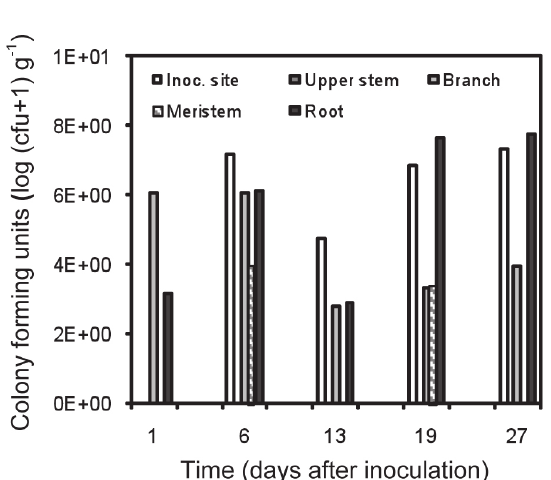
Figure 2. Location and movement of Pseudomonas syringae pv. c oriandricola ( Psc ) within coriander plants. Two-week- old plants were inoculated with a normal growth-rate rif mutant of Psc in the crown, and 1-cm sections of roots, stems, petioles and leaves were taken at weekly intervals and the bacteria extracted and dilution-plated to estimate CFUs g -1 . On day 1 the quantity of bacteria at the inoculation site were too numerous to